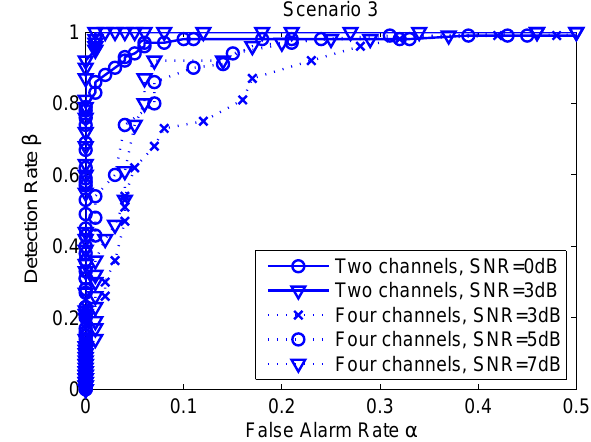
Figure 13. Detection rate versus detection time in three scenarios in the cases of two channels and four channels, respectively.